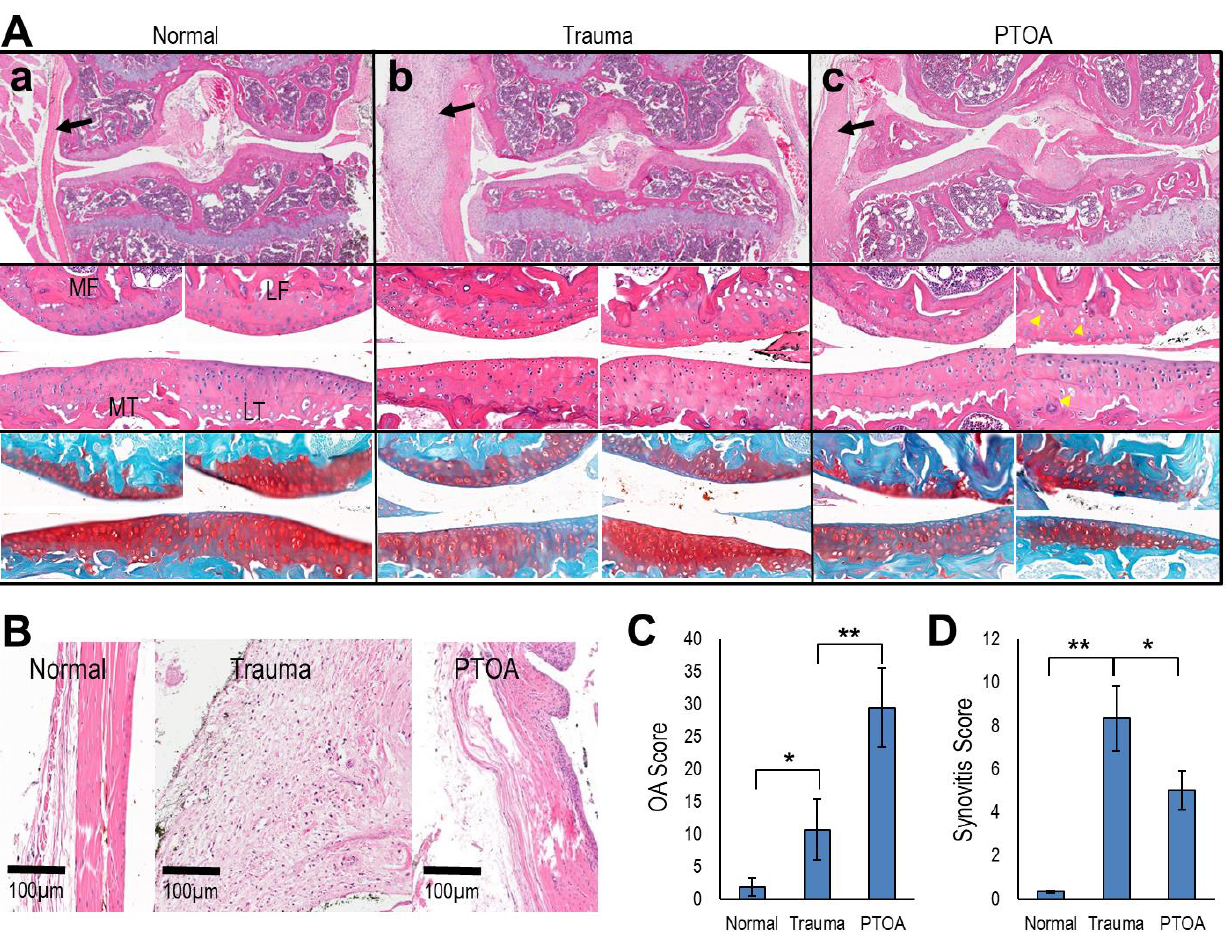
Figure 6. Histopathology of knee joints, synovial membrane, and scoring according to OA and synovitis score. ( A ) Representative H&E stain of whole knee joint under the following conditions ( a ) normal, ( b ) trauma and ( c ) PTOA. Observe inflamed synovial membrane as indicated by black arrows. Magnified images of the same knee joint show four distinct regions of the knee joint (middle panel). Cell distribution is affected by cartilage damage (yellow arrowhead). Safranin-O/Fast Green stain of the same knee joint (lower panel). Proteoglycan loss is obvious in Trauma and PTOA groups. Symbols: MF = medial femur, LF = lateral femur, MT = medial tibia, and LT = lateral tibia. ( B ) Representative H&E stain of synovial membrane. ( C ) OA score and ( D ) synovitis score. Data are represented as mean ± SD. * p < 0.05 and ** p < 0.01. (n = 6 per group).